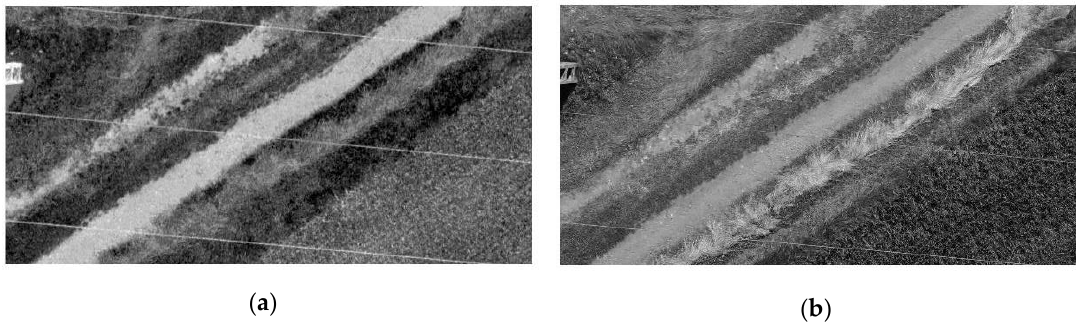
Figure 7. The same part of an example image showing power lines: ( a ) the band corresponding to the original blue band, obtained by the decorrelation stretching of the raw image; ( b ) weighted arithmetic mean of all bands (0.2989 × R + 0.5870 × G + 0.1140 × B).